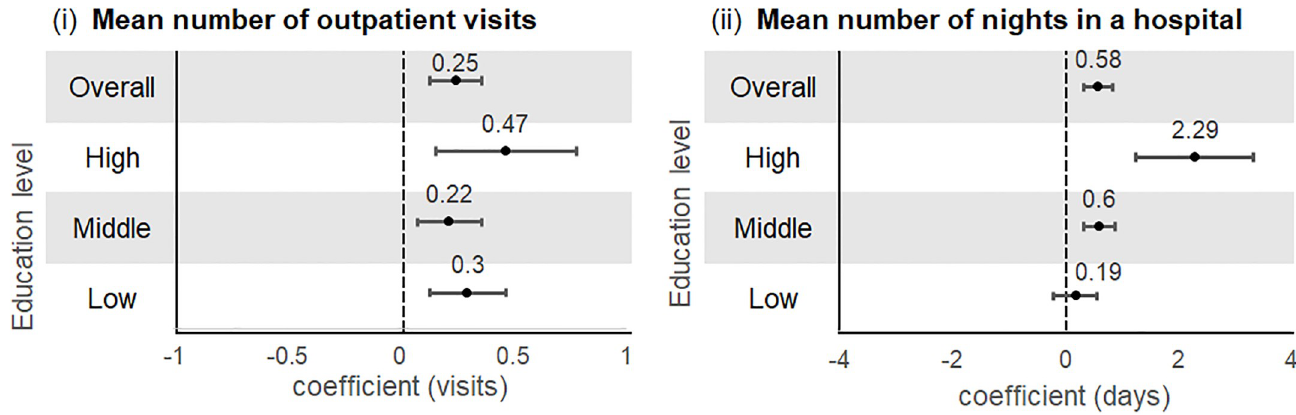
Fig 6. Associations between multimorbidity with mean number of (i) outpatient visits and (ii) nights in hospital by education level (Japan) + . + Multivariable negative binomial regression models were adjusted for age, sex, marital status, employment, body mass index, physical activity, alcohol intake, and smoking.